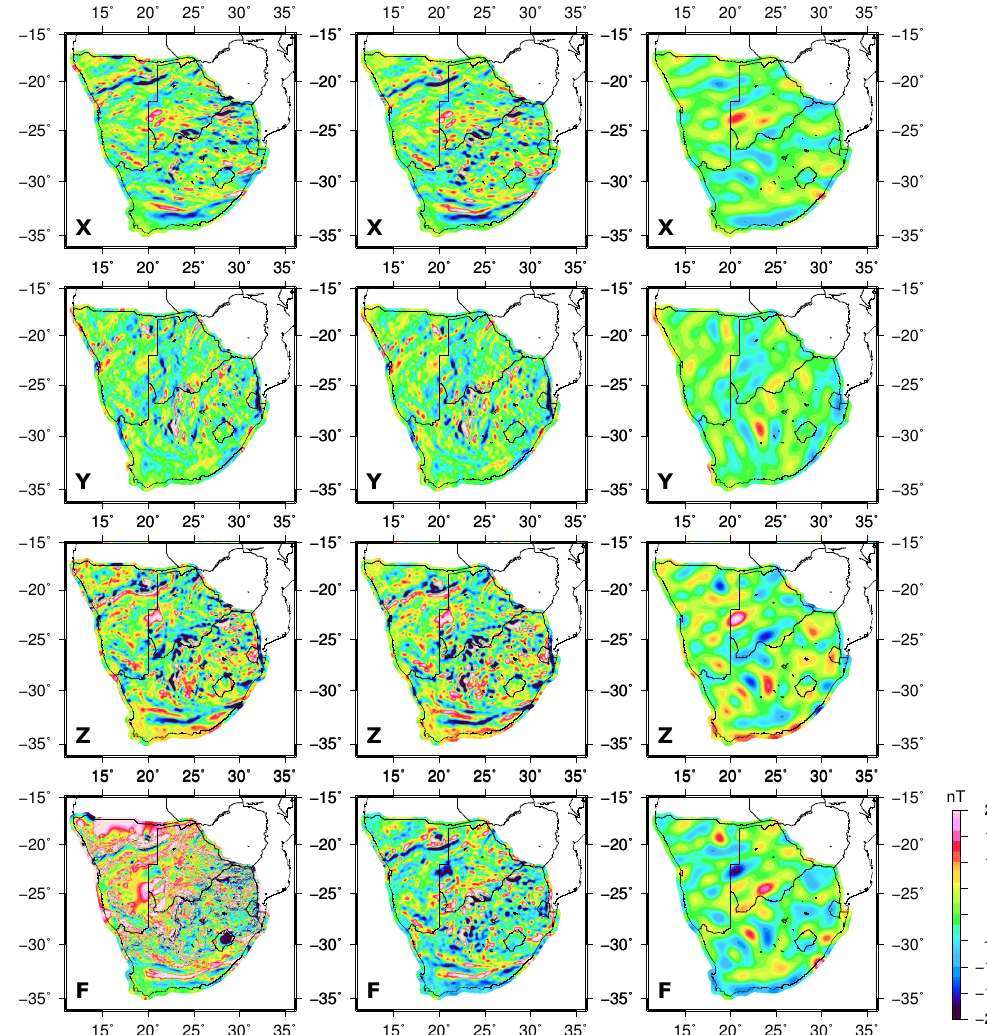
Figure 4. Different lithospheric field maps for southern Africa: regional R-SCHA model (orthogonal components) by Vervelidou (2013) and scalar high-resolution grid (M. Hamoudi, personal communication, 2014) as described in text and shown in Fig. 3a (left), global EMM2010 model of full (spherical harmonic (SH) degrees 15–720) resolution (middle) and truncated (SH degrees 15–200) EMM2010 (right). North ( X ), east ( Y ), vertical ( Z ) anomaly components and scalar total field ( F ) anomaly from top to bottom. All maps are on the same colour